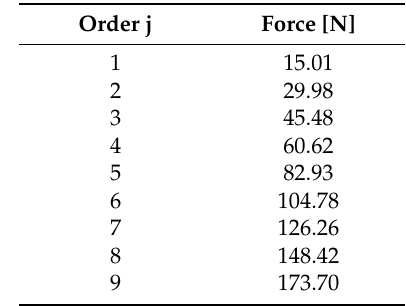
Table 1. Load by application of the F r